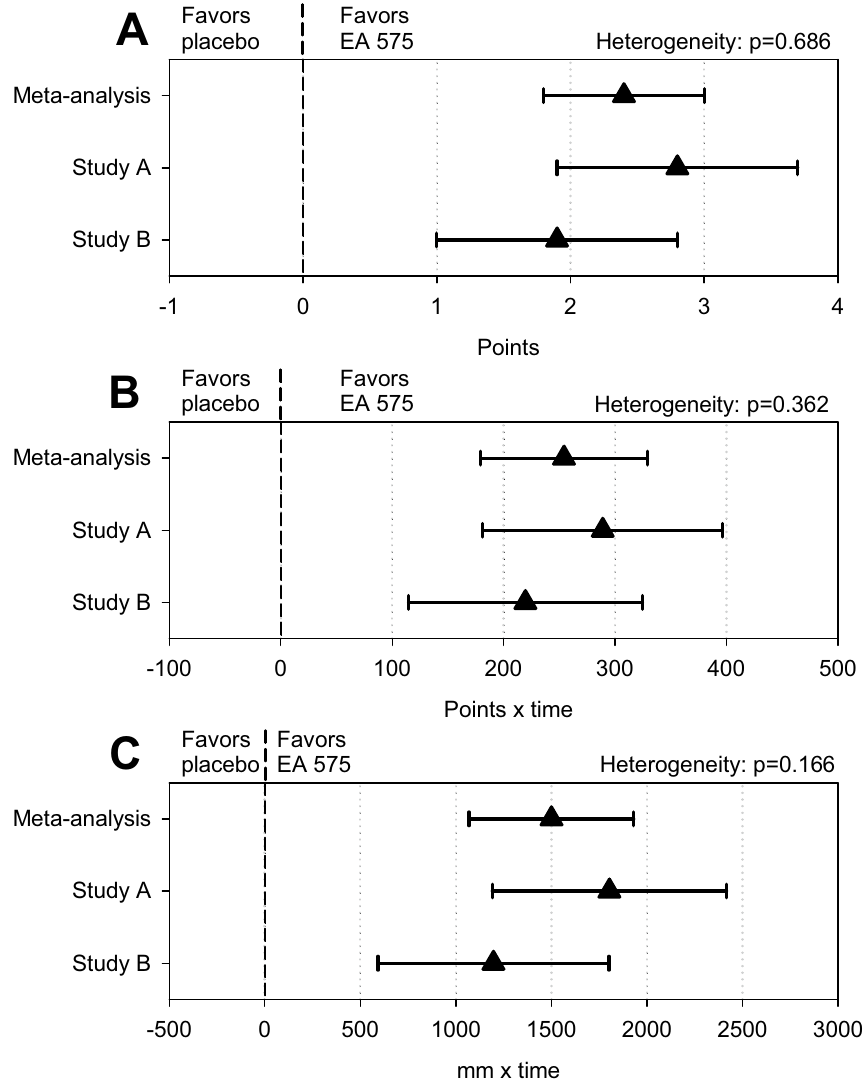
Figure 2. Forest plots of meta-analysis main results (full analysis set; marginal means and 95% confidence intervals as well as p-value for heterogeneity). ( A ) Bronchitis Symptom Score, Day 7 (treatment end); ( B